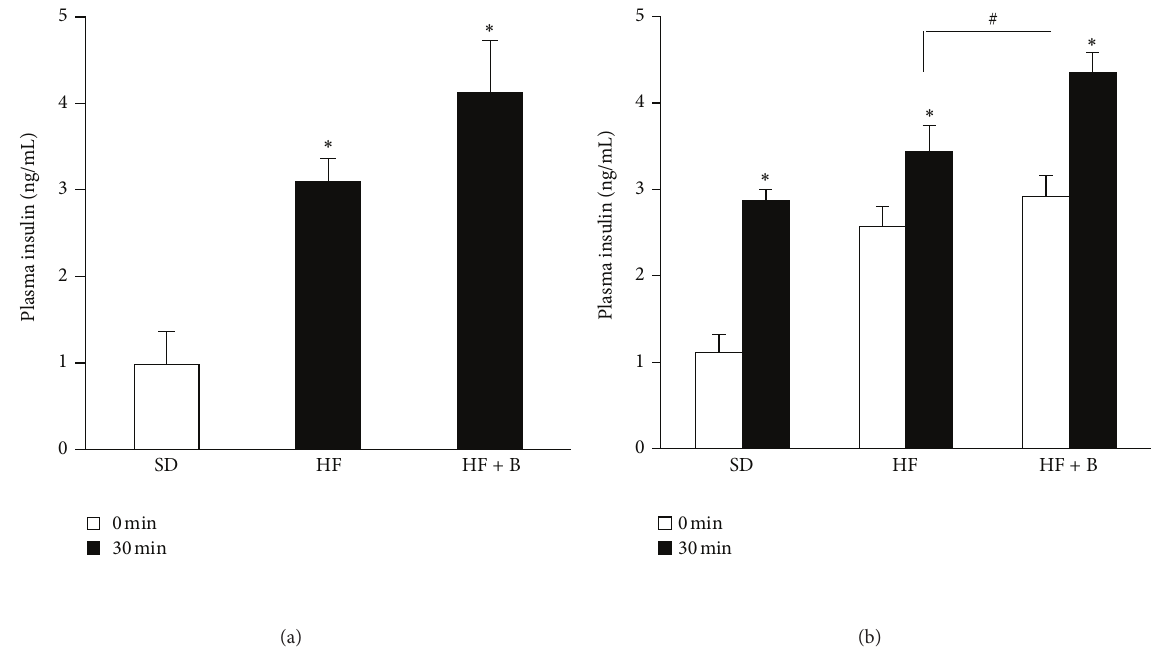
Figure 3: Dietary baicalein intake enhanced glucose-stimulated insulin secretion in obese mice. Fasting plasma insulin concentrations (a) were determined by ELISA after mice were fasted for 12 h. Plasma insulin concentrations at baseline and 30 min postglucose loading via ip injection (1g/kg BW). Data are means ± SEM ( 𝑛 = 10 mice/group). ∗ 𝑃 < 0.05 versus SD group; # 𝑃 < 0.05 versus HF group. SD: standard diet, HF: high-fat diet, and HF + B: HF + 0.5 g baicalein/kg